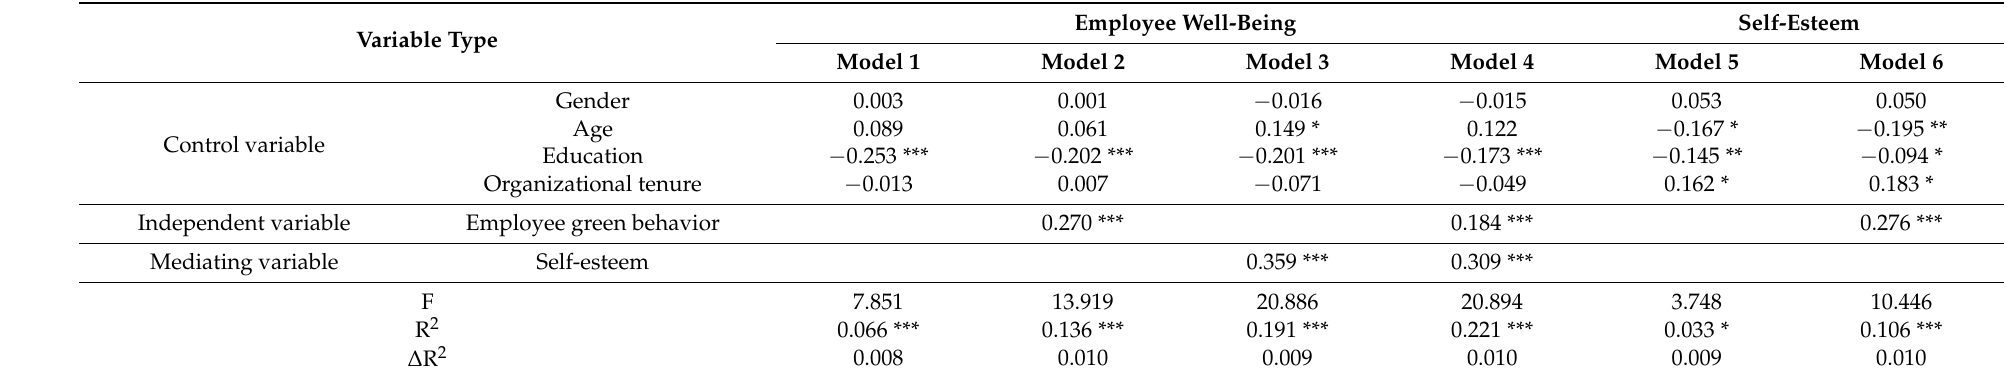
Table 4. Mediating role of